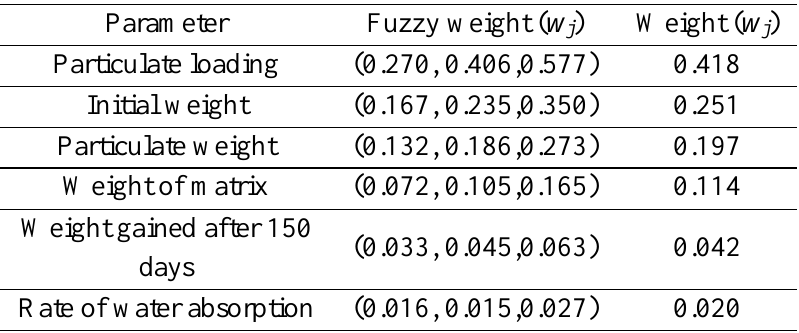
Table 6. Defuzzification of parametric